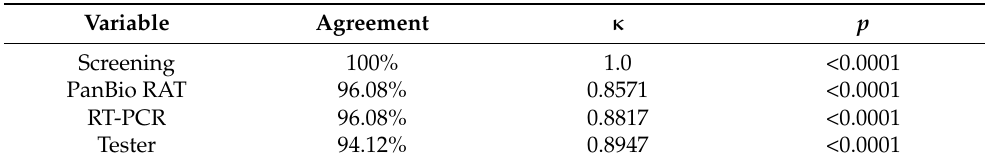
Table 2. IRR for variables: screening, Panbio RAT, RT-PRC, and Tester calculated for subset n = 51